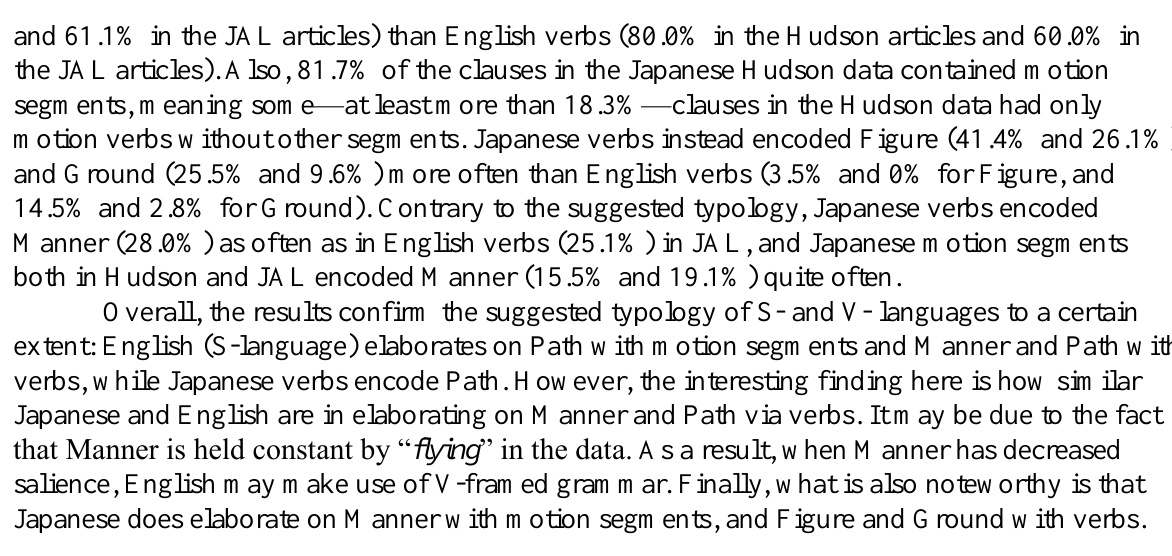
Numbers and Examples of Each Verb Type in Four Data Sets